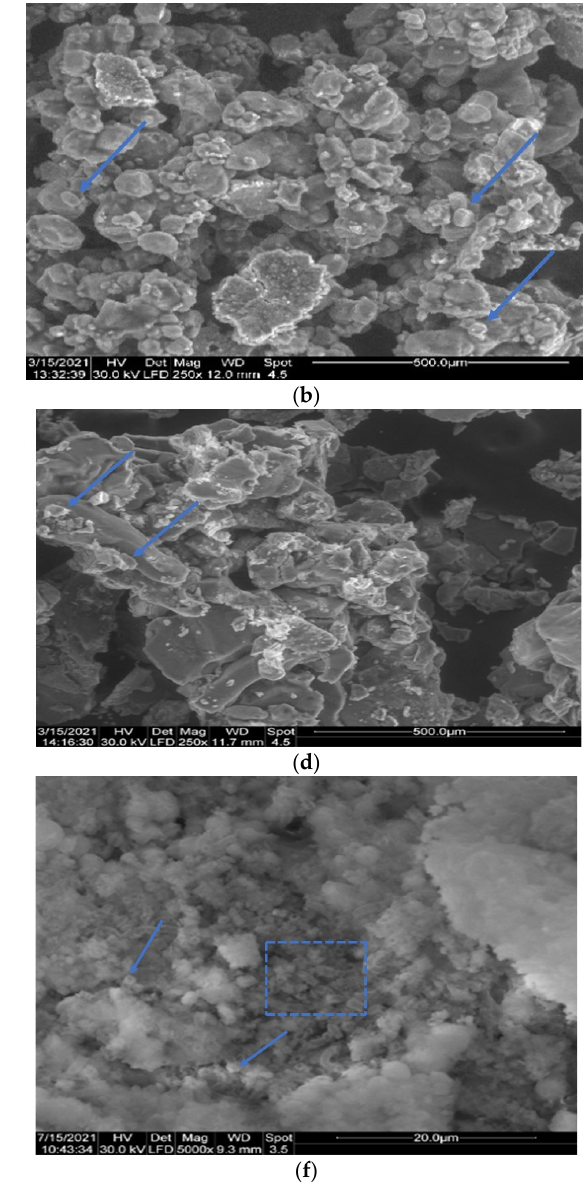
Figure 5. Microscopic investigations of deposits obtained from bacteria cultured on medium with urea and calcium ions. On left, optical microscopy is shown, and on the right, SEM analysis, as: ( a ) Spores and crystals carbonate from Bacillus amyloliquefaciens (20×); ( b ) SEM analysis of pellet from Bacillus amyloliquefaciens ( 250×); ( c ) Spores and crystals carbonate from Bacillus licheniformis (20×); ( d ) SEM analysis of pellet from Bacillus licheniformis (250×); ( e ) Crystals carbonate and germens of crystallization at Bacillus subtilis (100×); ( f ) SEM analysis of deposit from Bacillus subtilis (5000×). Dotted square ‐ bacterial cells; arrow—calcium carbonate crystals.